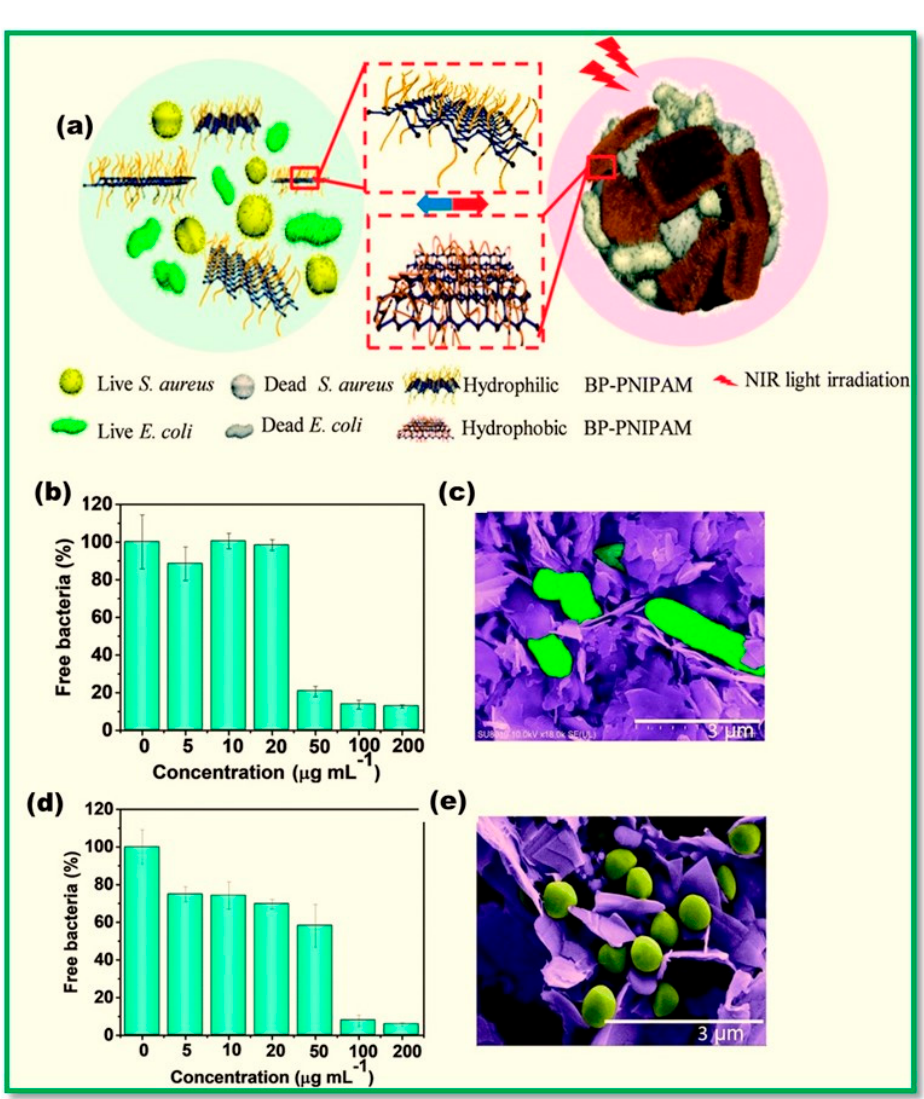
Figure 28. ( a ) The process of NIR-triggered bacterial capture and elimination by BP–PNIPAM; ( b ) and ( c ) the capacity of BP–PNIPAM for capturing E. coli ; ( d ) and ( e ) the capacity of BP–PNIPAM for capturing S. aureus . The numbers of free E. coli ( b ) and S. aureus ( d ) in the supernatant under treatment with different concentrations of BP–PNIPAM; the control experiment was performed by adding sterile water and leaving to stand for 5 min; SEM images of E. coli ( c ) and S. aureus ( e ) treated with BP–PNIPAM at 100 µg mL − 1 . All the treatments were performed under 5 min NIR (808 nm, 2 W cm − 2 ) irradiation. The scale bar is 3 µm.